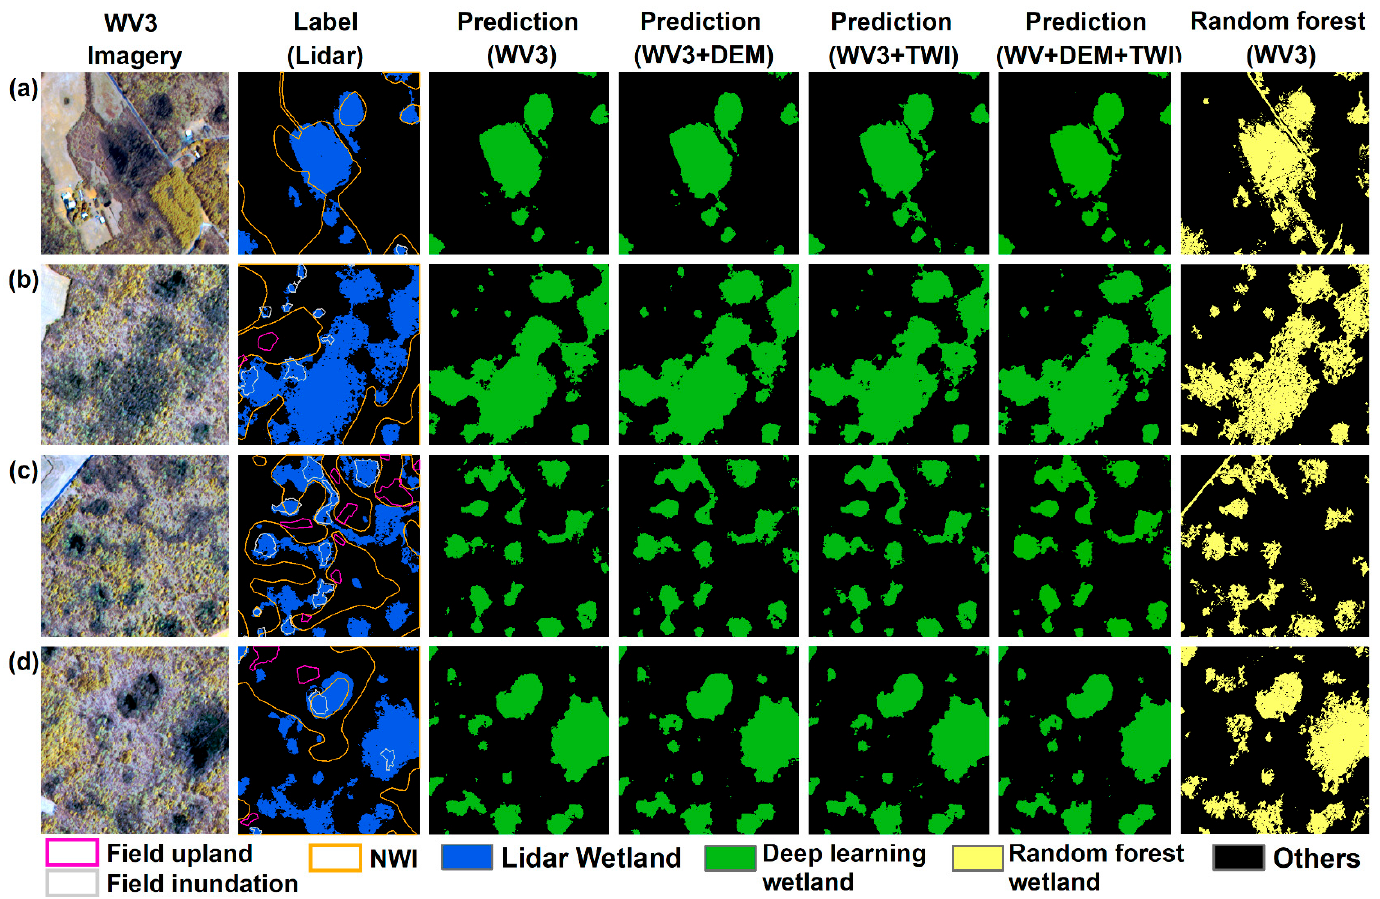
Figure 7. Comparison of forested wetland inundation predicted in our study with the lidar intensity-derived inundation labels, the random forest output, and the NWI geospatial dataset, which depicts wetlands. The variables in the parentheses are the data input used for our deep learning network or the random forest model. We randomly chose four image patches ( a - d ) out of 64 validation image patches as examples.